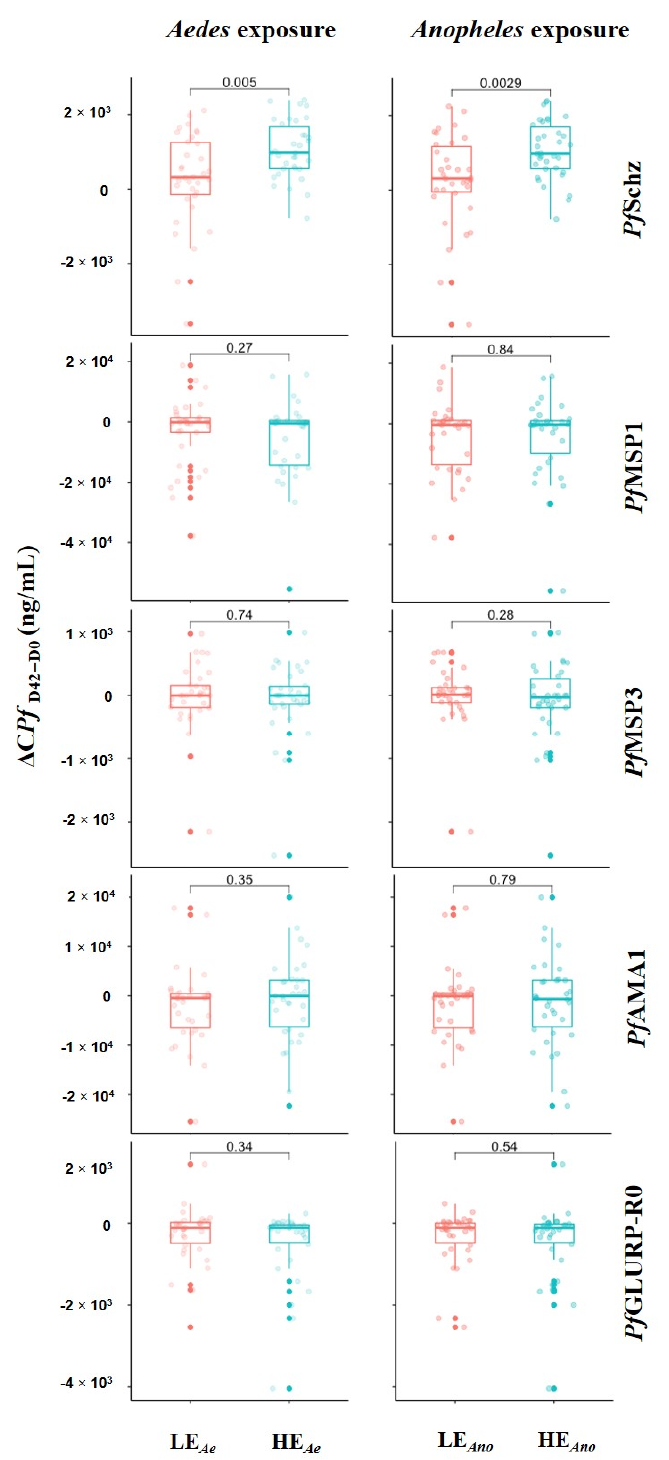
Figure 1. Variation in concentration of IgG response to P. falciparum antigens according to group of exposure to Anopheles and to Aedes (single-genus exposure). Participants were grouped according to their level of IgG response to Anopheles (lower exposure (LEAno) < ∆ ODgSG6-P1 = 1.41 < higher -exposure (HEAno)) and to Aedes (lower exposure (LEAe) < ∆ ODNterm-34 kDa = 1.10 < higher exposure (HEAe)) salivary peptide. Each dot represents an individual, and box plots indicate the median values, 25th and 75th percentile antibody concentration for each P. falciparum blood-stage antigen. Statistically significant difference in median value between the two groups is indicated (Mann–Whitney U